Question: Judging by this figure, is the value going up or going down?
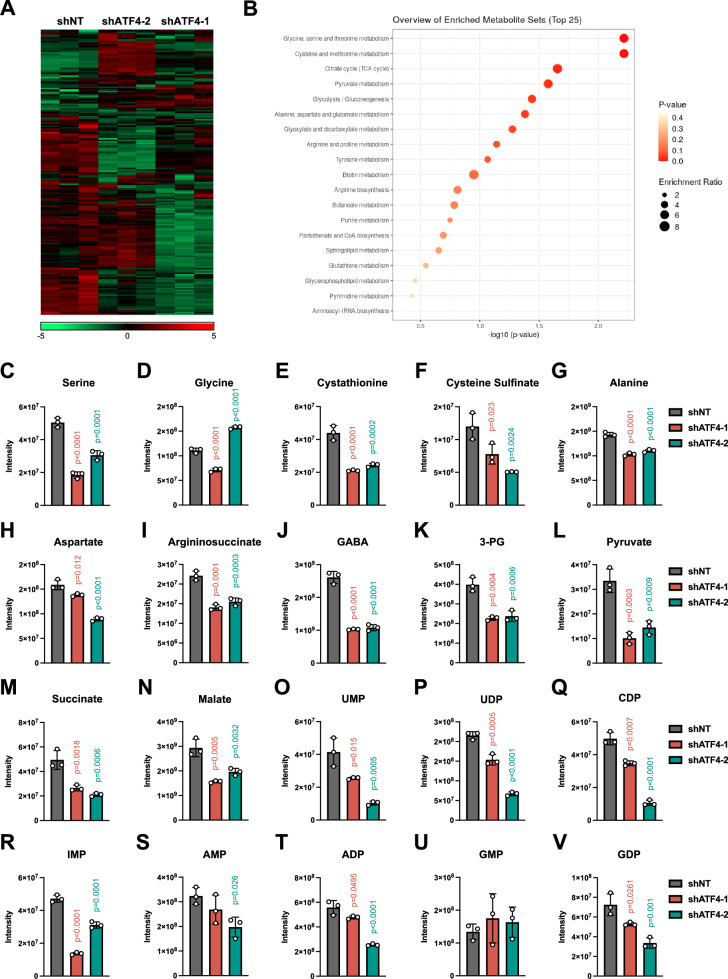
Answer: decreasing